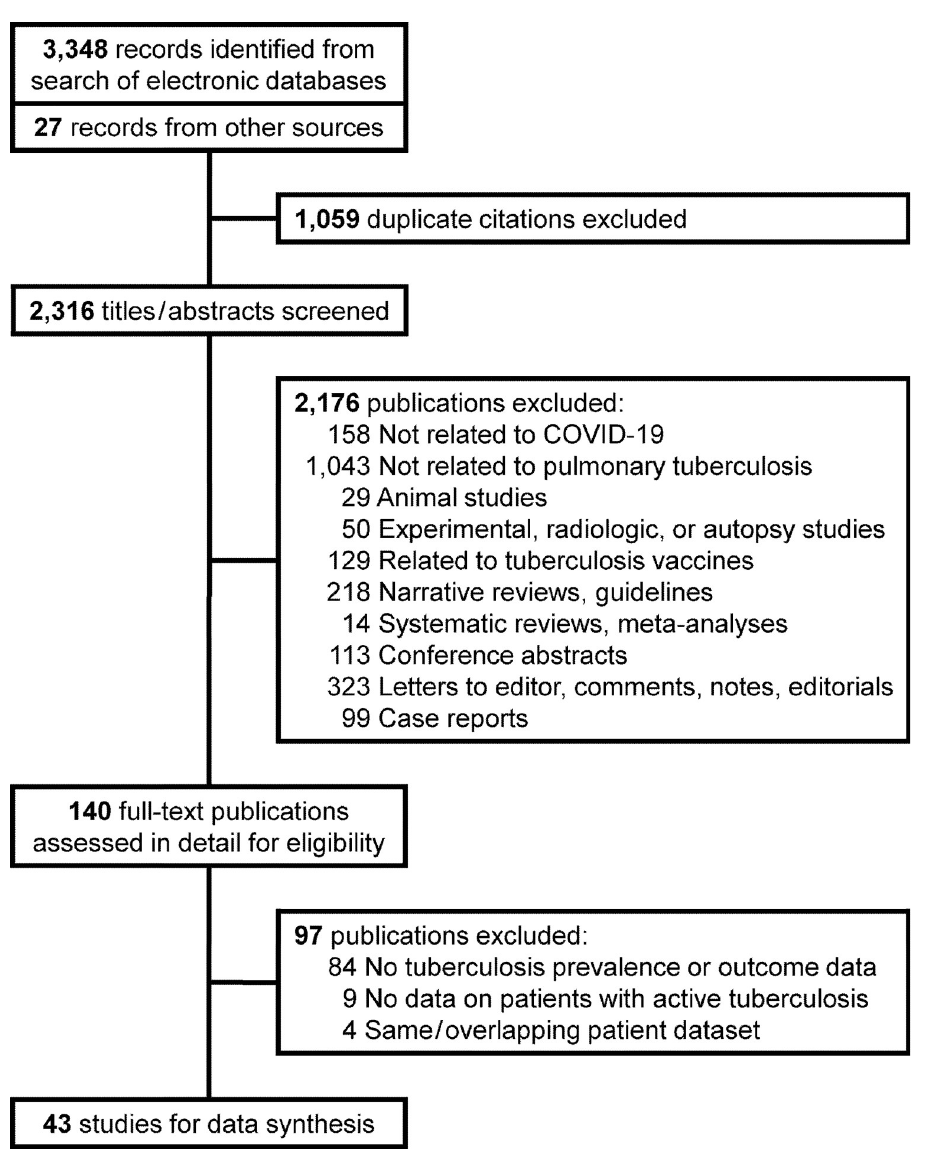
Fig 1. Flow chart for study